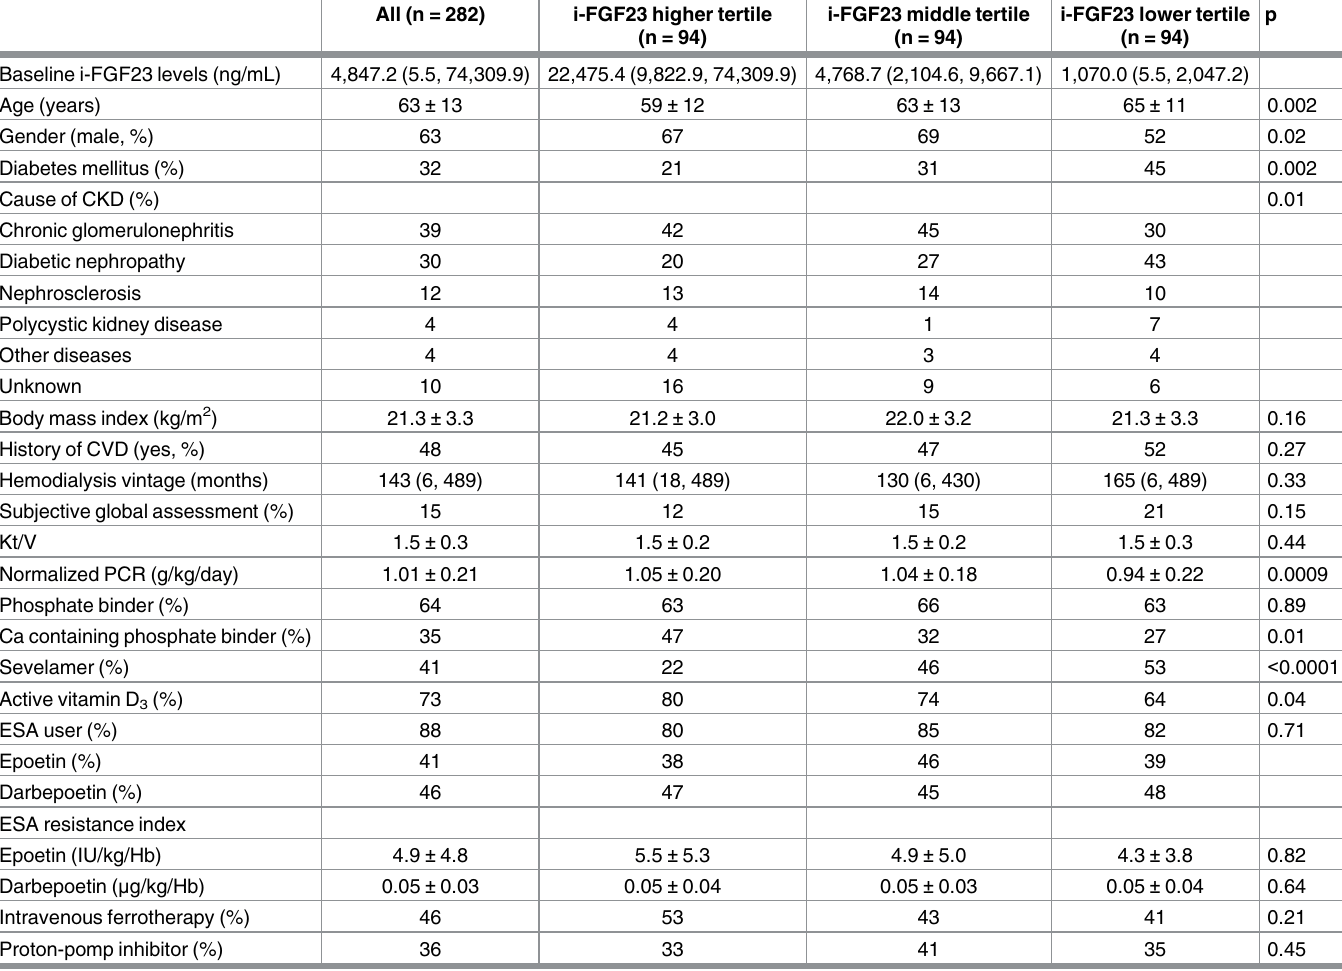
Table 1. Patients’